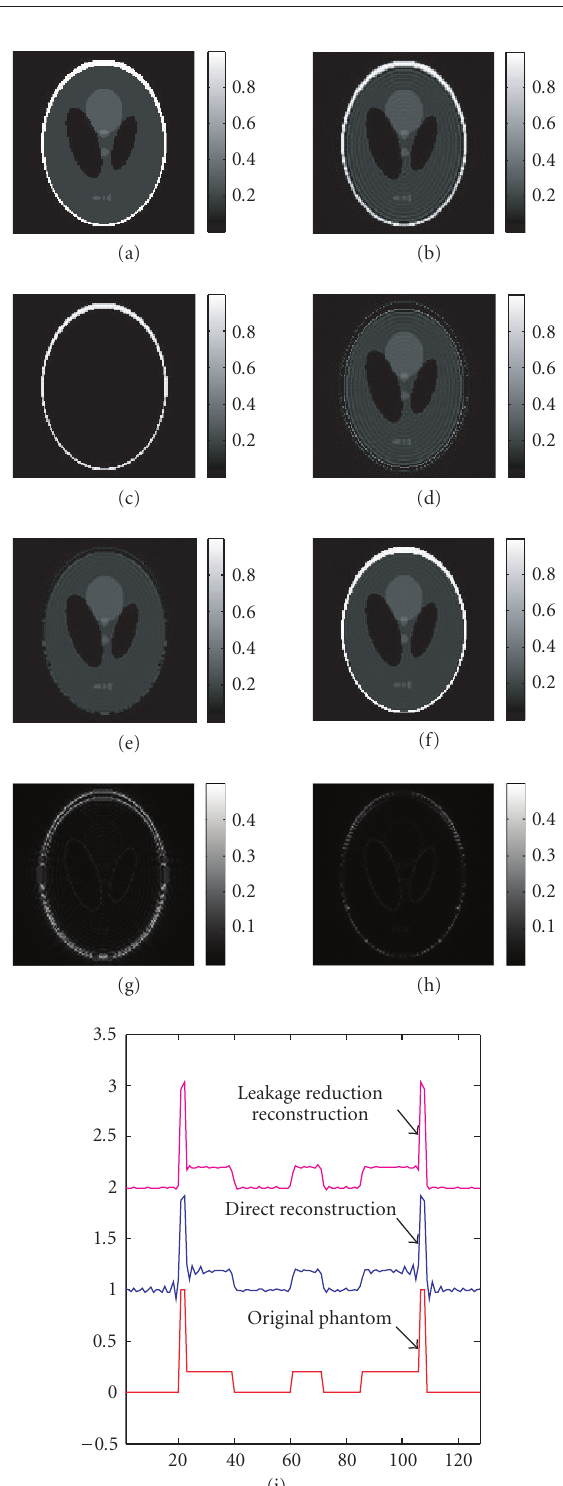
Figure 4: Shepp-Logan phantom reconstructed from spiral sam- ples. (a) Original Shepp-Logan phantom image. (b) Direct recon- struction. (c) Highest discontinuity to be subtracted. (d) Remain- ing image after subtraction of (c). (e) Reconstructed remainder im- age after one iteration. (f) Final leakage reduction reconstruction. (g) Absolute di ff erence image of direct reconstruction. (h) Absolute di ff erence image of leakage reduction reconstruction. (i) Center line profiles of the reconstructed